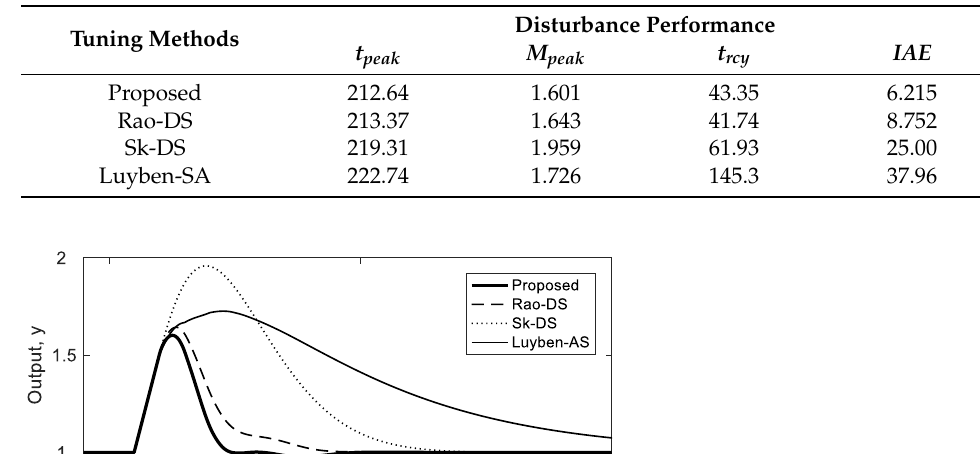
Table 3. Quantitative comparison of responses to disturbance in perfect model of PIPTD.